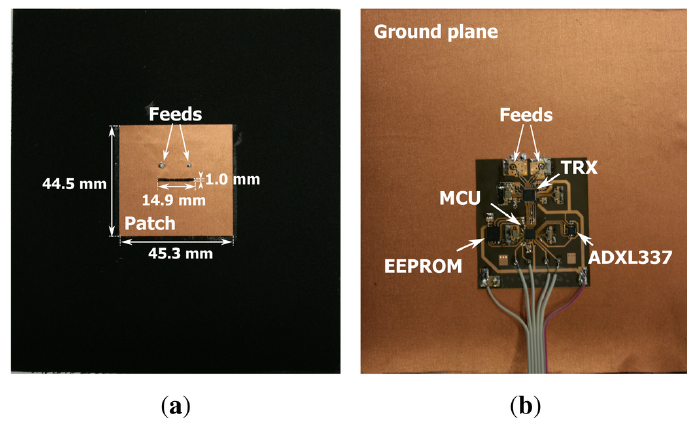
Figure 1. ( a ) front view of the wireless sensor node; ( b ) back side of the wireless sensor node with the electronic components mounted on the flexible